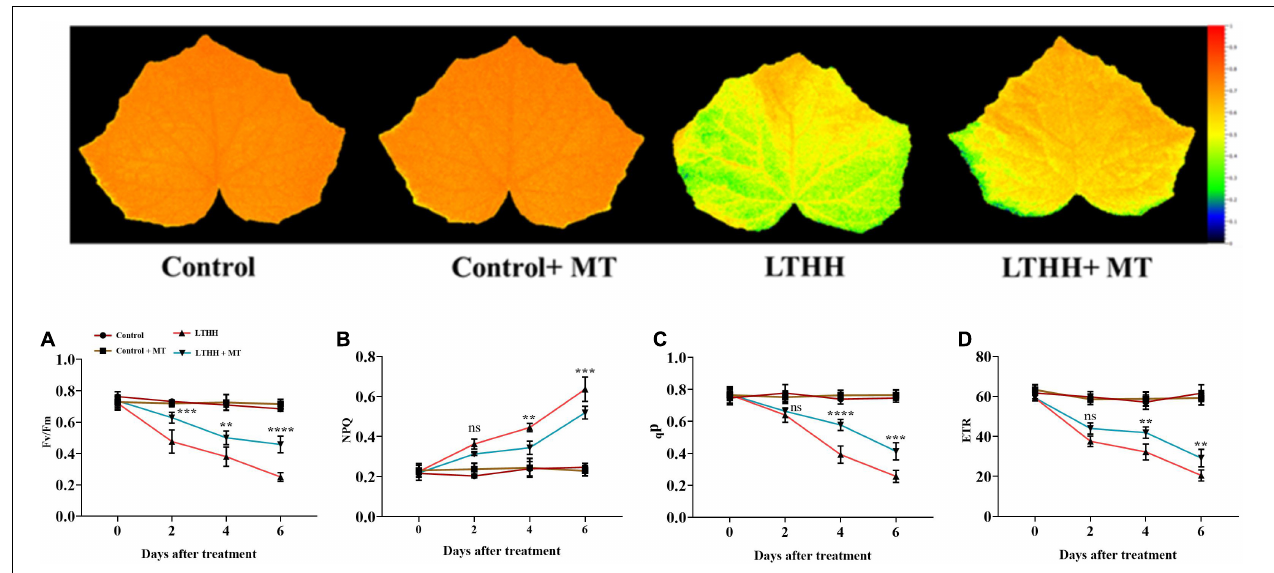
FIGURE 2 | Effect of exogenous melatonin on chlorophyll fluorescence parameters PSII maximum efficiency (A) , non-photochemical quenching (B) , photochemical quenching (E) , and electron transport rate (D) of cucumber seedling under low-temperature and high-humidity stress. Control (25/18 ◦ C); Control + MT (200 µ M melatonin, 25/18 ◦ C); LTHH (15/10 ◦ C, 95%); LTHH + MT (200 µ M melatonin, 15/10 ◦ C, 95%). Results were presented as means ± SD ( n = 3), significance values were presented as: * P < 0.05; ** P < 0.01; *** P < 0.001; **** P < 0.0001; while non-significant (ns) ( P >